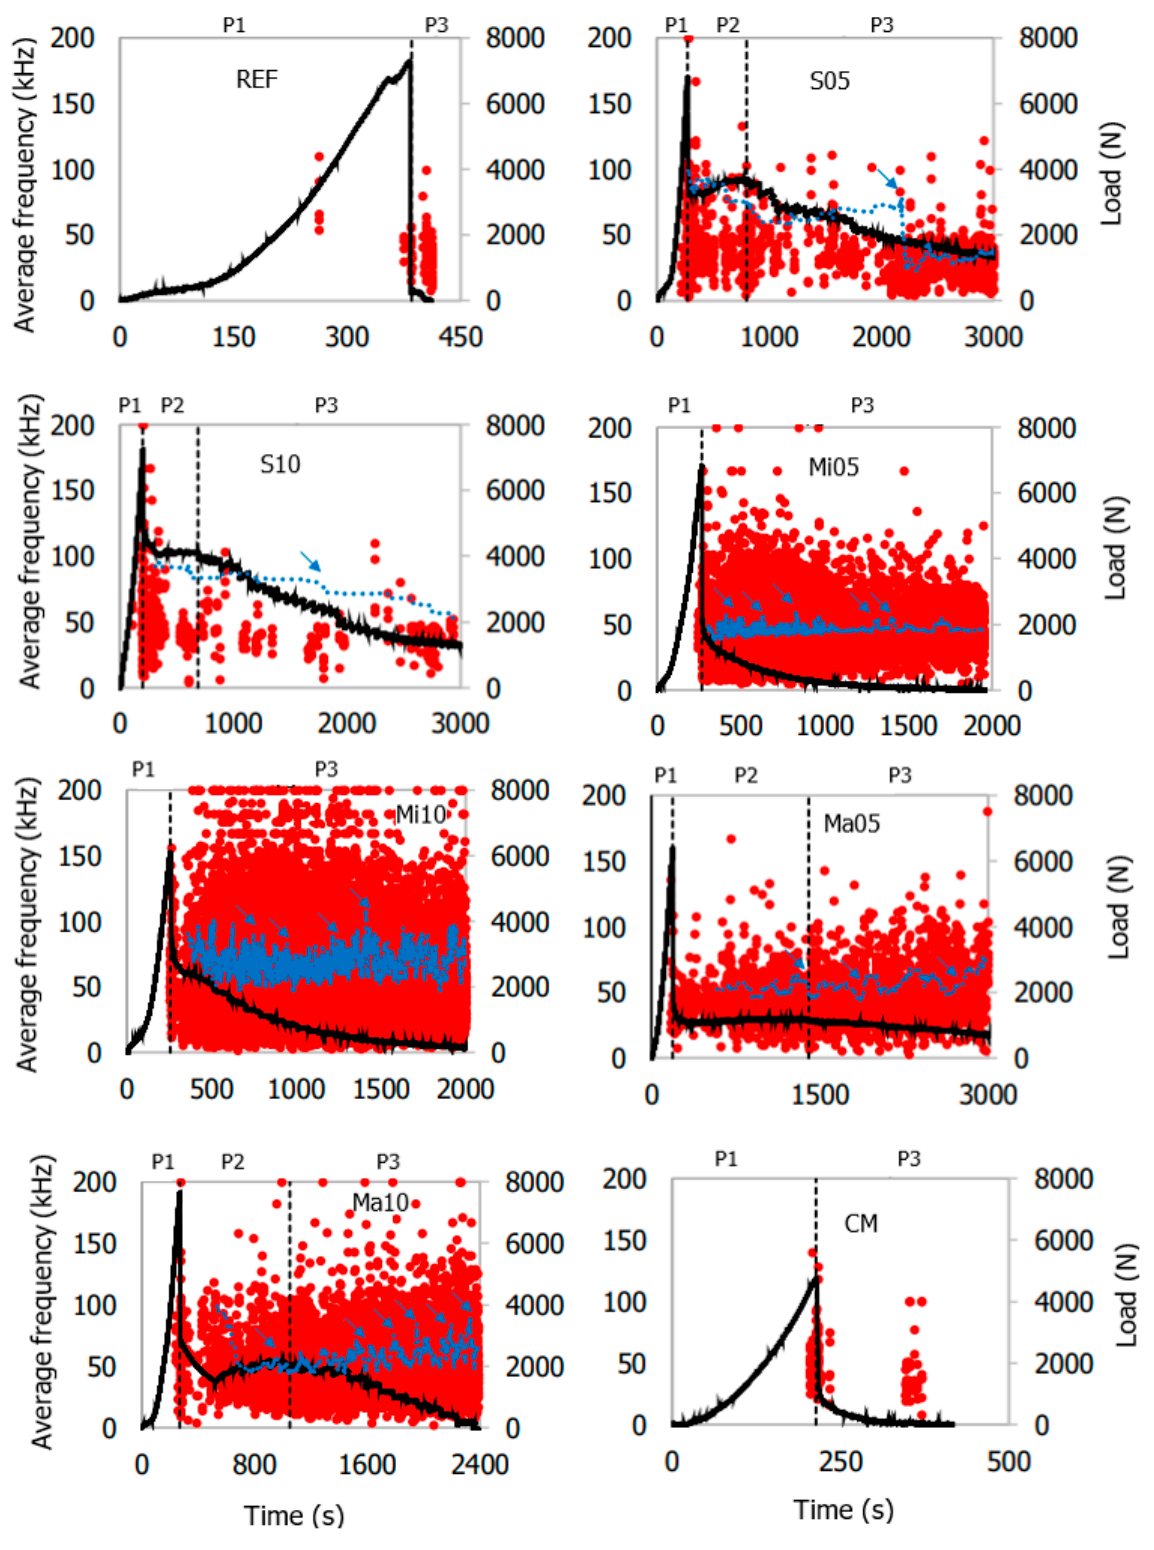
Figure 13. Average frequency distributions of the AE activities ( ● Average frequency, ● ● ● Moving average of average frequency, ― Load).